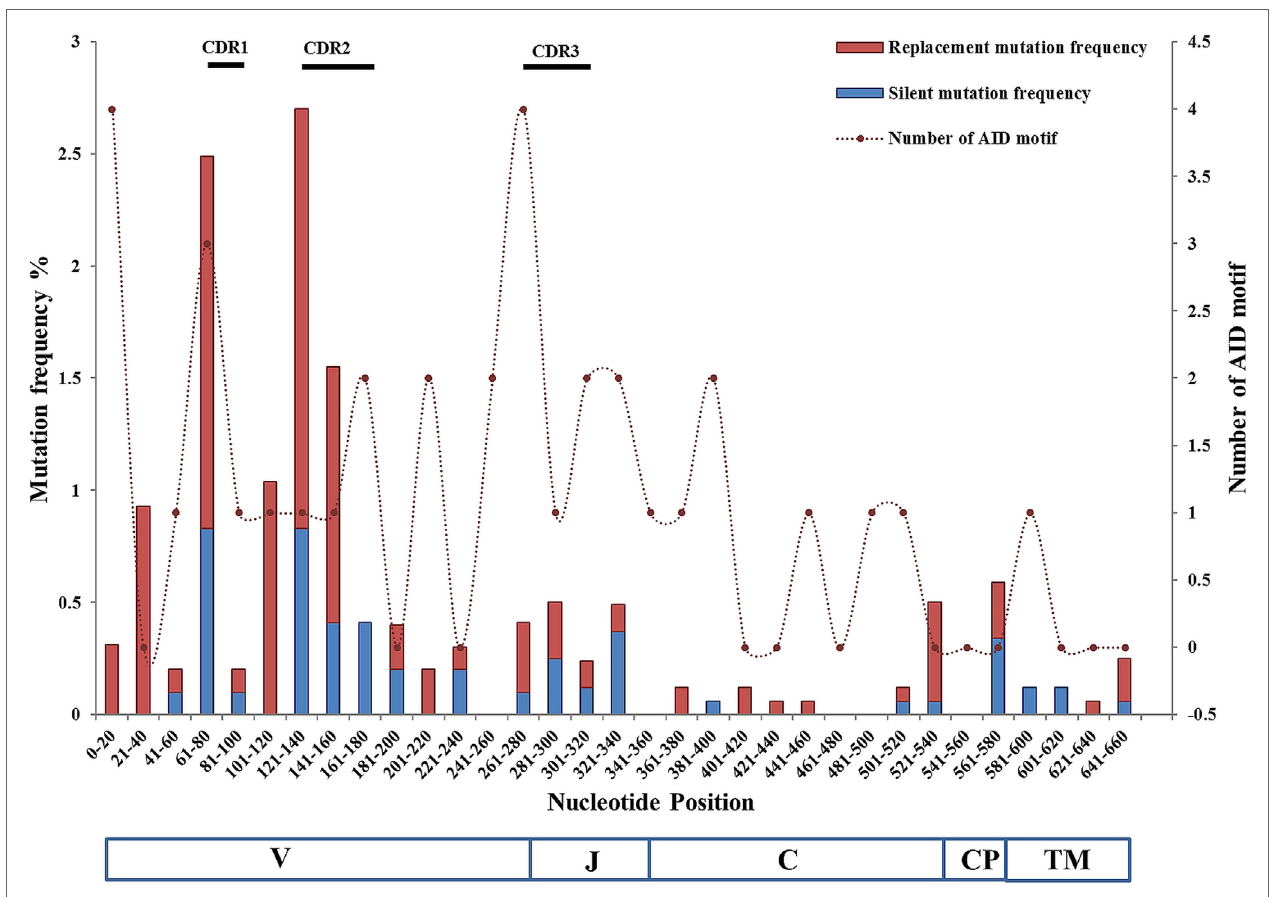
FigUre 5 | Distribution of mutation frequencies and number of activation-induced cytidine deaminase (AID) hotspot motifs in VJ and C regions of Ballan wrasse TCR α cDNA clones. The frequencies of silent and replacement mutations are plotted at the left vertical axis, while numbers of AID motifs are plotted at the right vertical axis; against nucleotide position intervals. The VJ region represents the combined mutation frequencies of 48 unique VJ cDNA clones, while the C region represents 79 unique cDNA clones. Numbers of AID hotspot motifs are represented as dashed lines. The diagram also indicates the location of V, J, and the constant Ig, connecting peptide, and TM regions. Primers included the first nine nucleotides of the V gene and the cytoplasmic region of C α and were, therefore, not included in the mutability analysis. Position of the CDRs is depicted as bars over the